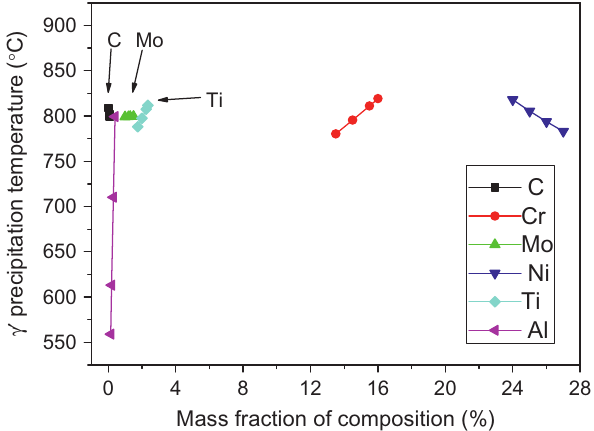
Figure 9: Influence of different elements on solution temperature of γ ′